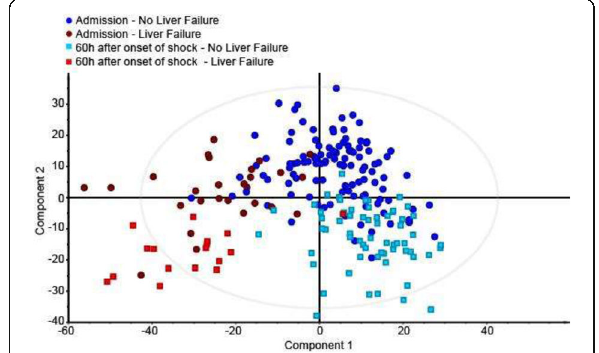
Figure: PLS-DA scores plot (R 2 0.41, Q 2 0.31, p< 0.001) showing the different metabolic trajectories over the first 60h after the onset of septic shock in patients with and without liver failure (Liver SOFA >1)